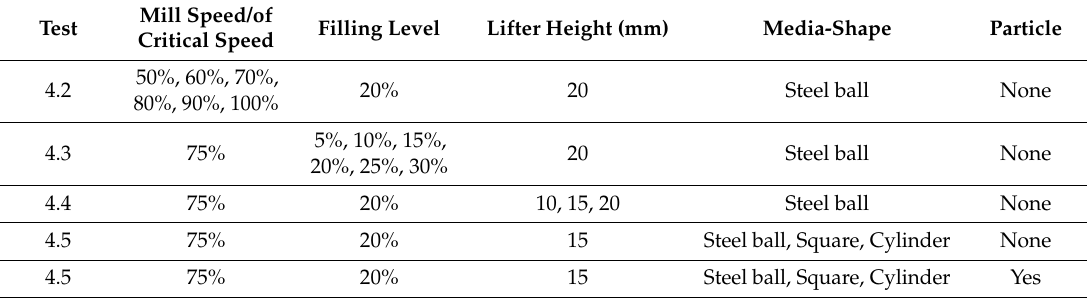
Table 1. Experimental conditions.